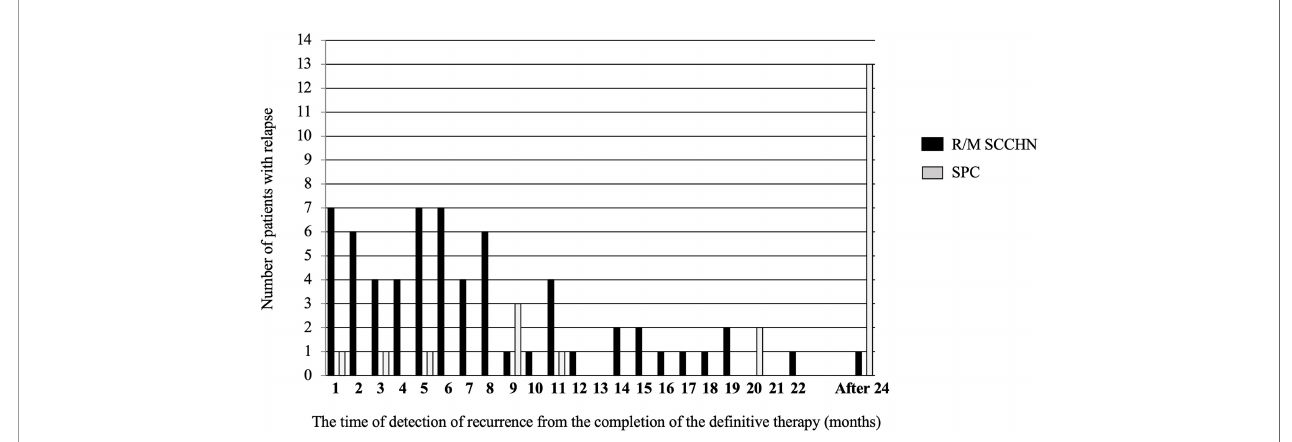
FIGURE 2 | Histogram for the time of the detection of recurrence after de fi